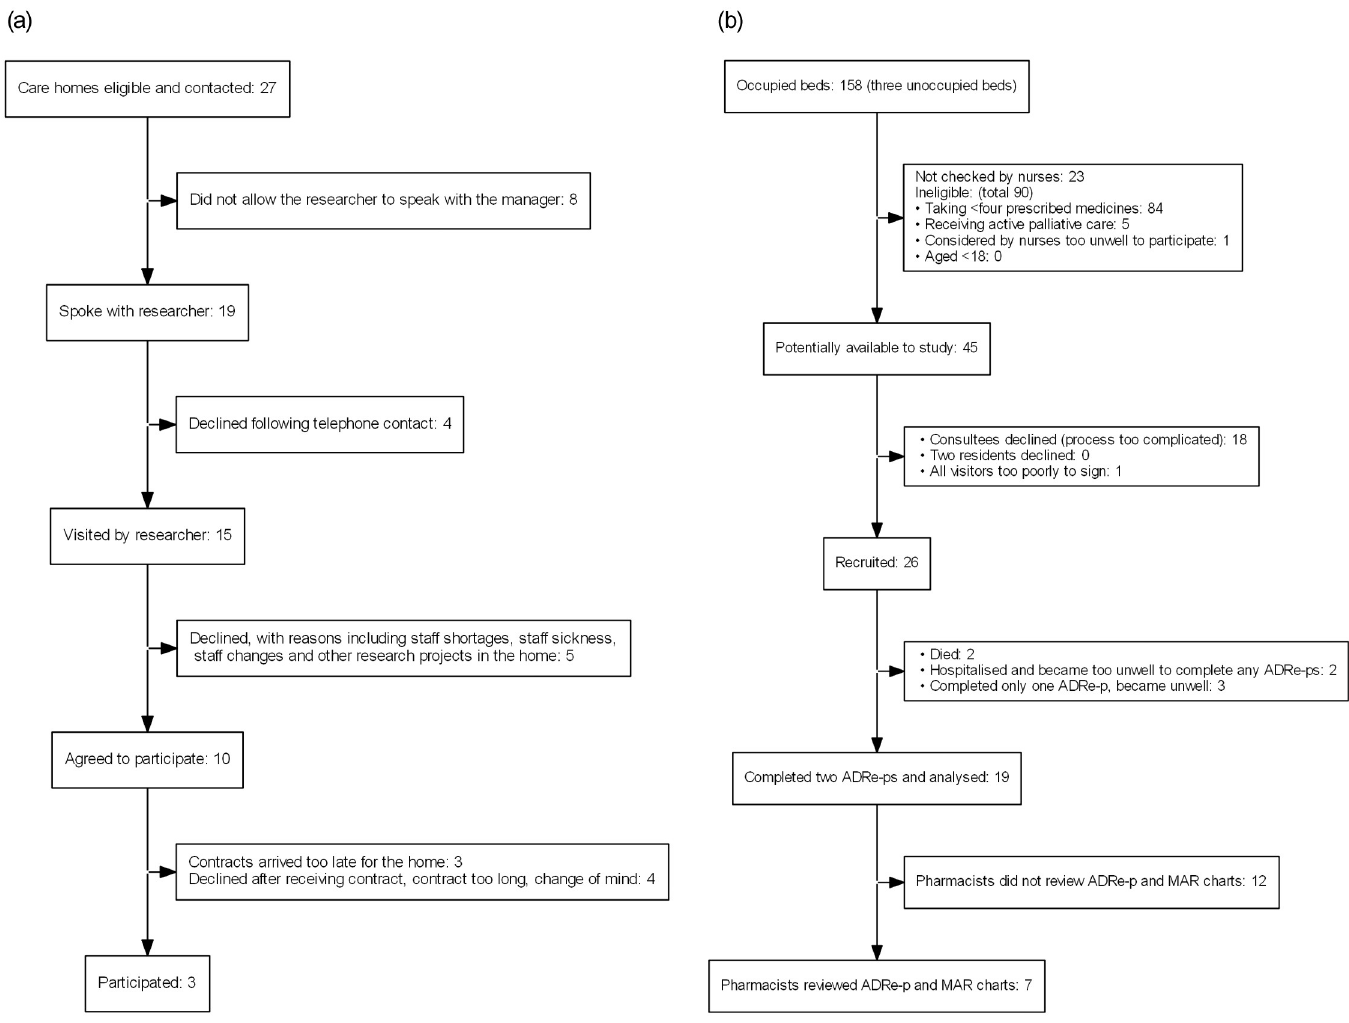
Fig 2. a. Care home recruitment: Flow diagram. b. Resident recruitment: Flow